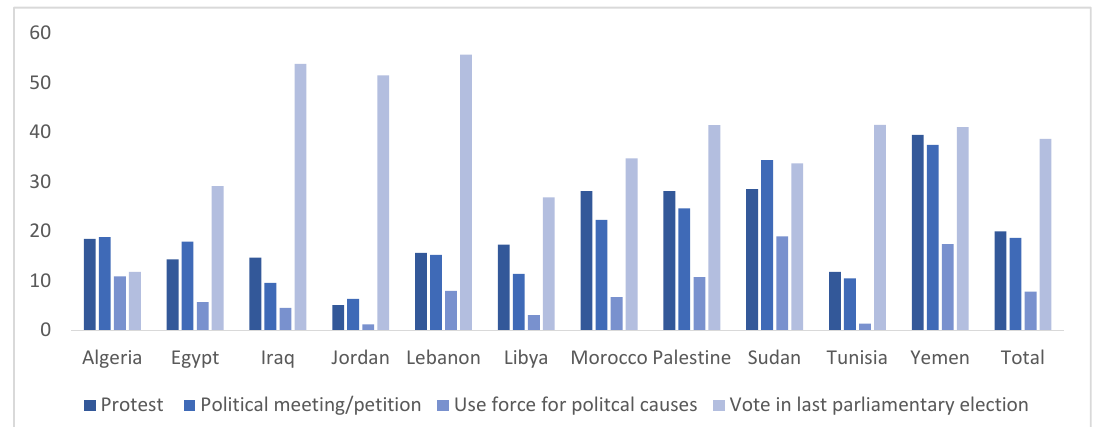
Figure 8. Percentage of people having participated in politics during 2015-2018/2019. Source: Arab Barometer Survey Fifth wave (2018–2019). Available online: https://www.arabbarometer.org/survey-data/data-downloads/ (accessed on 15 July